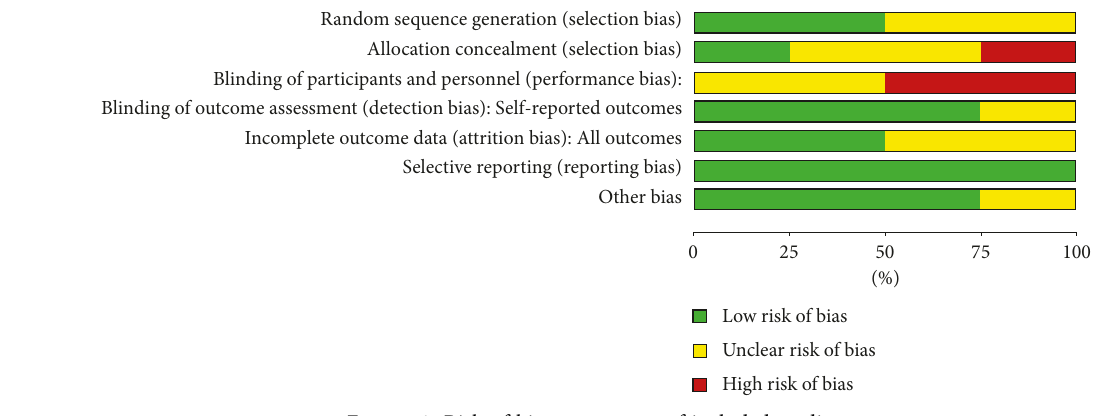
Figure 2: Risk of bias assessment of included studies.